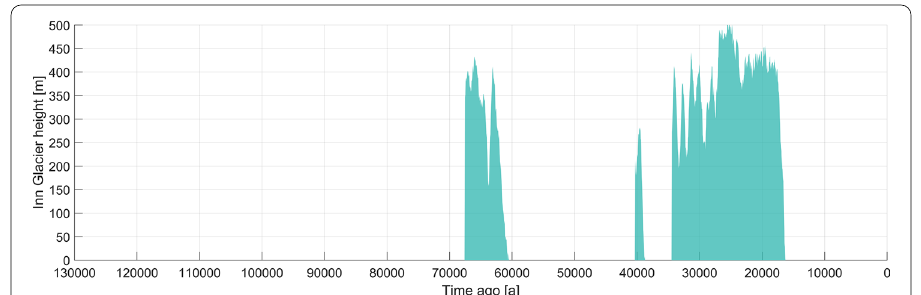
Fig. 6 Evolution of the Inn Glacier height in the Alpine foreland during the Würm Glaciation (see also Seguinot et al. 2018). Glacier height is applied as time-dependent hydraulic head at the southern model boundary (Inn Glacier in Fig.